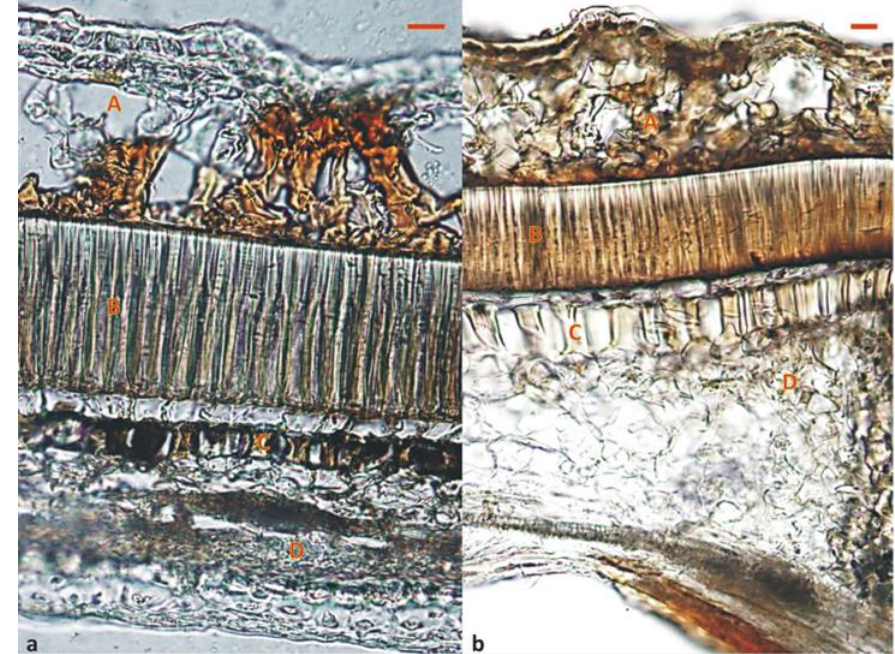
Figure 2. Longitudinal sections of the pods of ( a ) B. basaltica and ( b ) B. bituminosa . A = cellular structure of the pod wall (pericarp); B = palisade cell layer; C = osteosclereid layer; D = parenchyma layer. Bar = 20 μm.